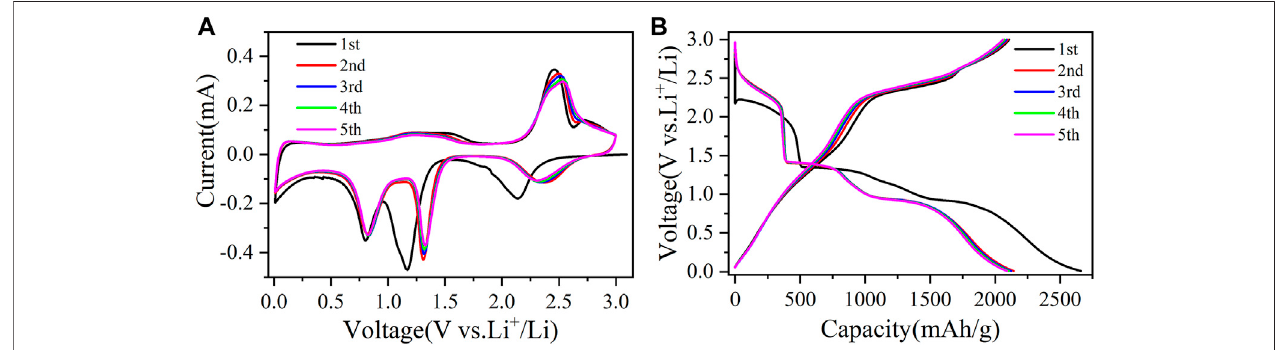
FIGURE5 | The fi rst fi ve cyclic voltammetry curves (A) at ascan rateof 0.1 mV/s and the fi rst fi ve charge-discharge curves (B) at a currentdensity of200 mA/g for CuO/Cu 2 O/Cu nanocomposites.